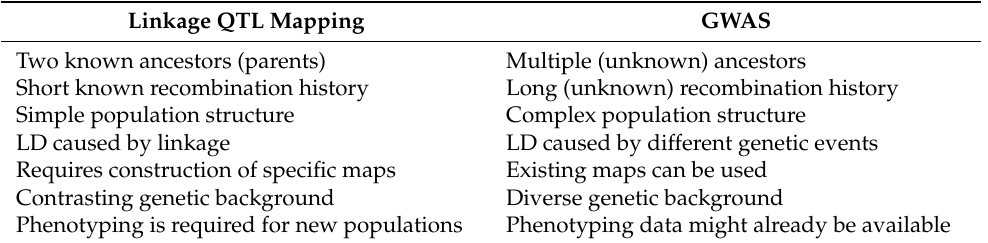
Table 3. Comparison between biparental QTL mapping and genome-wide association study